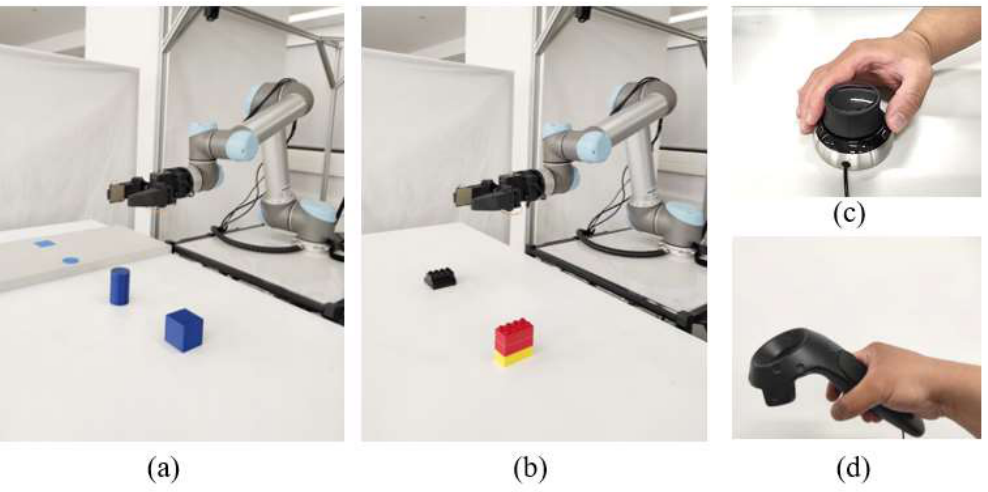
Figure 4. An overview of spatial manipulation tasks and command input methods. ( a ) Pick-and-place task of two cubical and cylindrical objects given a goal position with different heights; ( b ) assembly task involved grabbing one LEGO subassembly from a predefined spot and stacking it onto a fixed LEGO base on the table; ( c ) isometric-rate HRI scheme using the 6-DOF input device; ( d ) isotonic-position imitative HRI scheme using the Vive motion controller.